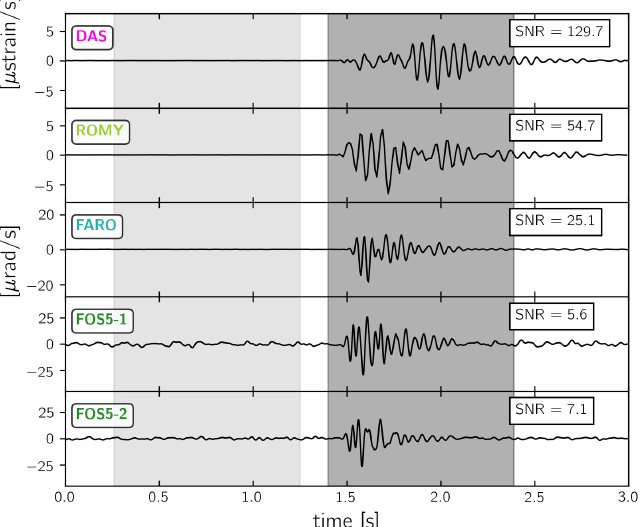
Figure 10. 30Hz low pass filtered waveforms from “expl2” (see Figure 1) recorded by 1C vertical rotation rate sensors and the DAS system at the point closest to the huddle test site. See Figure 9 for more